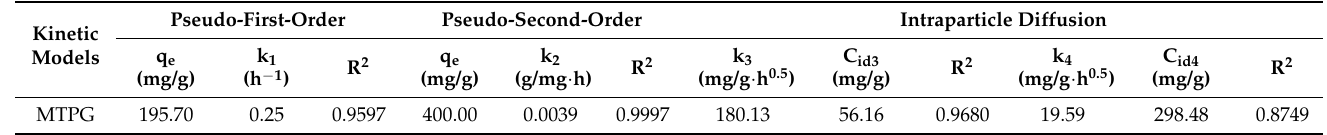
Figure 3. ( a ) Kinetics of phosphate sorption on MTPG and the pseudo-second-order fitting curve; ( b ) the intraparticle diffusion fitting curves (C 0 =1000 mg/L, MTPG = 0.4 g/L, pH=5, T=298 K). Table 2. Kinetic parameters of phosphate sorption on